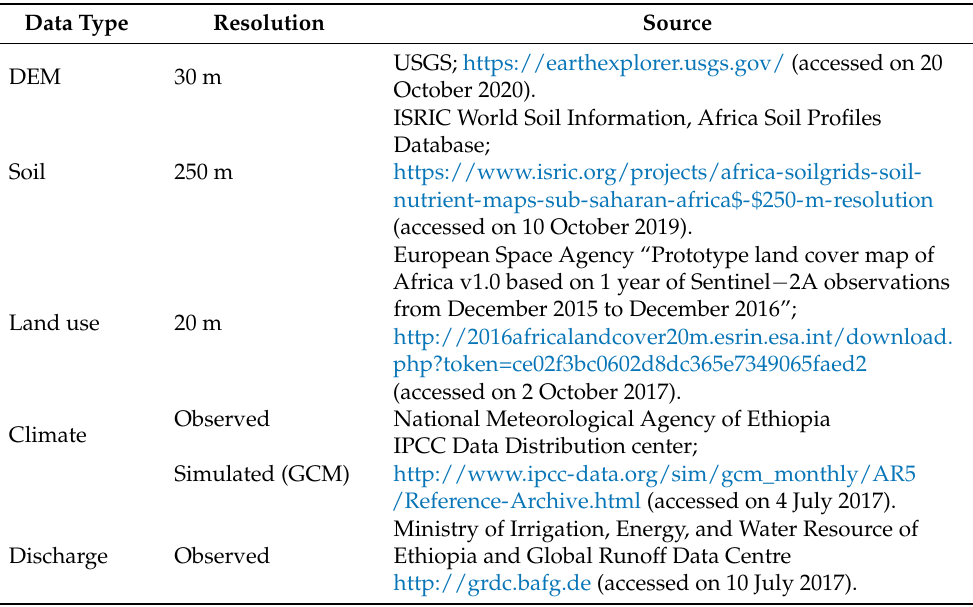
Table 3. Data type and sources used in SWAT model